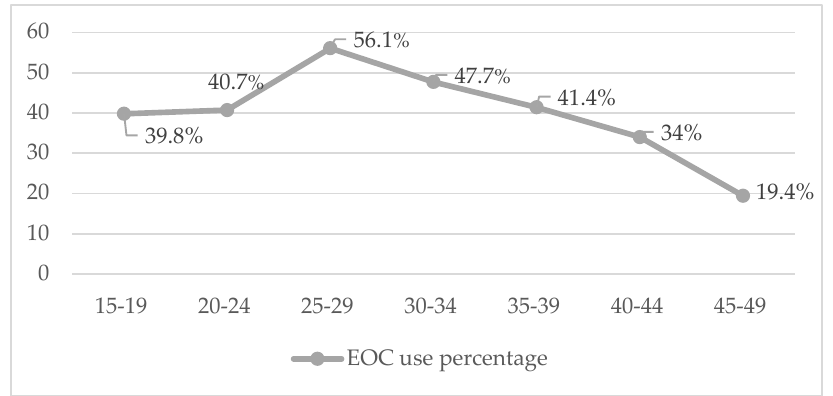
Figure 3. Use of the morning ‐ after pill according to age group.